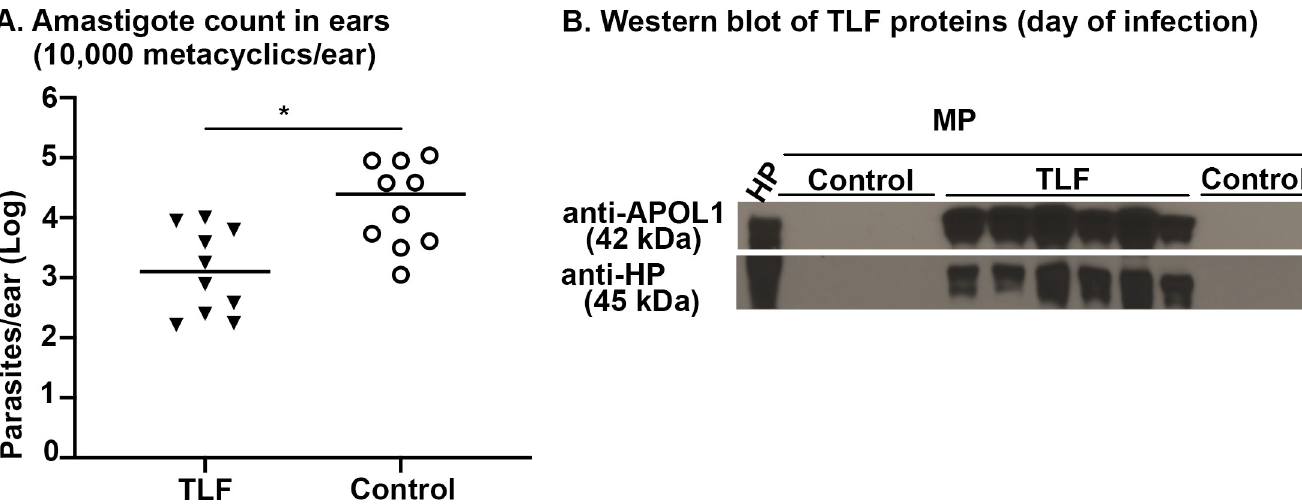
Fig 1. Human HDL reduces the parasite burden in a natural intradermal infection by L . major . A. Transiently transgenic mice were created by injecting 50 μ g of plasmid DNA containing human APOL1 : HPR genes (TLF) in a single plasmid by hydrodynamic gene delivery (HGD) followed by infection by 10,000 metacyclic promastigotes (1 day post-HGD). Control groups were injected empty vector plasmid. Parasite burden (amastigotes) was quantified by real time PCR, 15 days post- infection. The data represent Mean ± SD of one typical experiment that has been repeated four times �� p < 0.001 Mann-Whitney U test, n = 5 mice (10 ears) per group, 1 mouse from each TLF and control group was euthanized before 15 days due to tail inflammation. B. Western Blots of plasma samples from mice on the day of infection diluted 1:40 (mouse plasma, MP) n = 6 per group were performed to assess the production of the APOL1 (42 kDa) and HPR (45 kDa) proteins. HP (human plasma) diluted 1:40 was used as positive